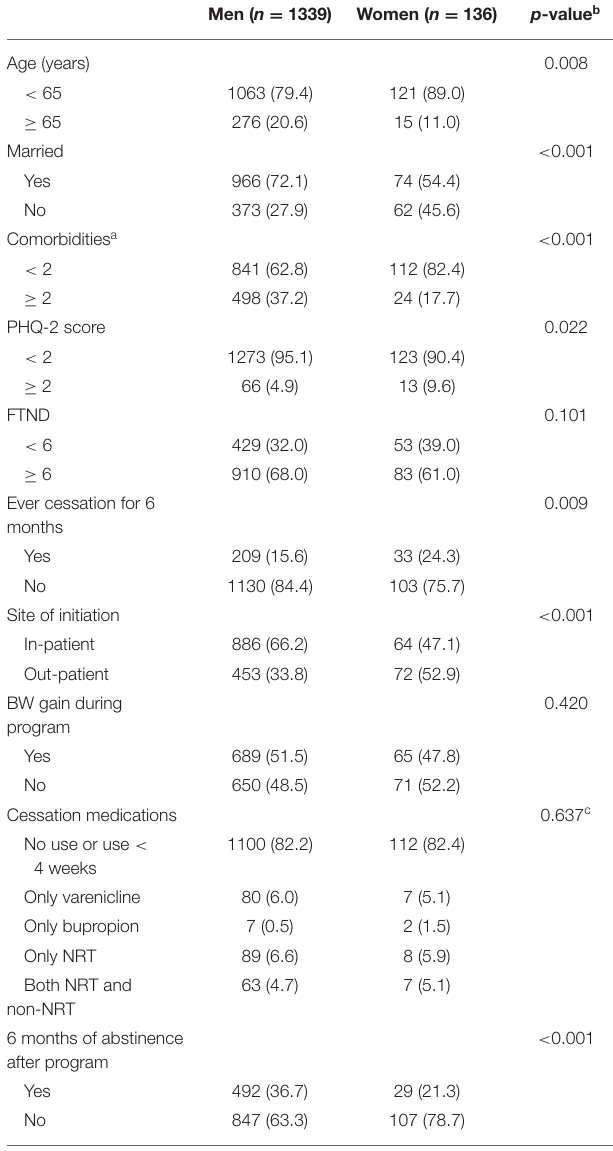
TABLE 1 | Characteristics of smokers participating in a smoking cessation